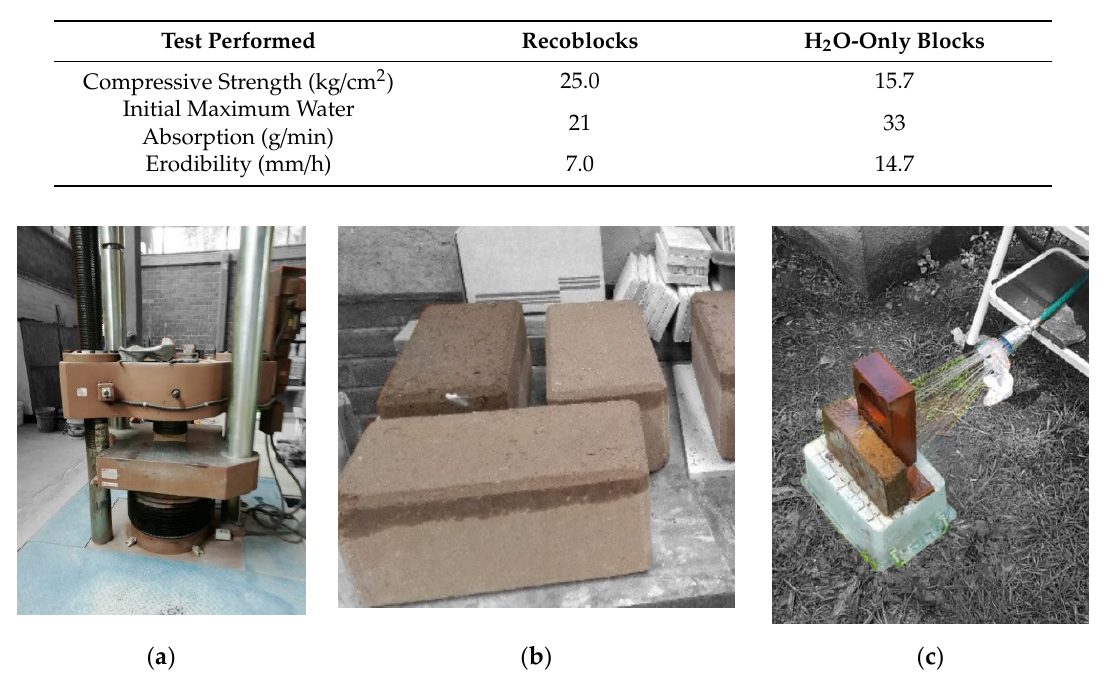
Figure 8. Qualitative results of compressive strength ( a ), initial maximum absorption ( b ) and erodibility ( c ), respectively.